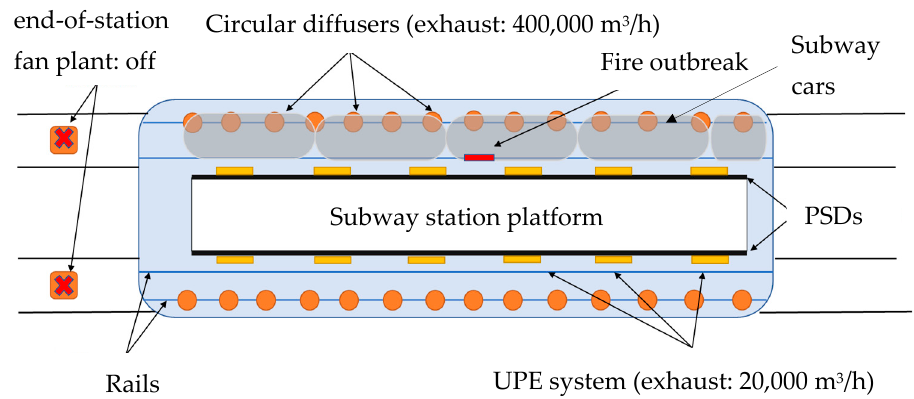
Figure 8. Ventilation emergency operating mode in the subway station.